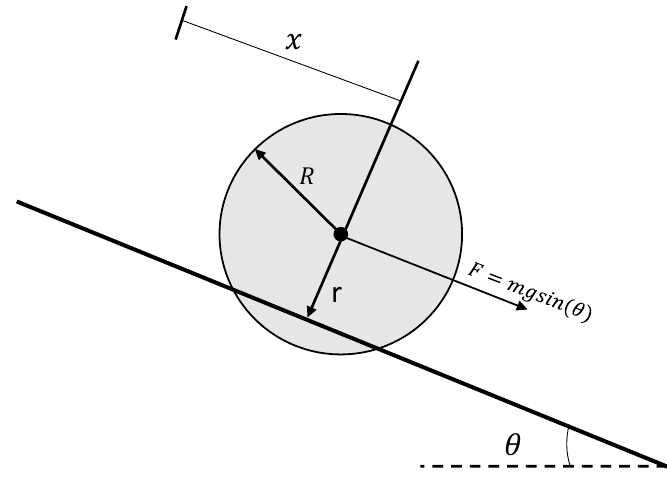
Figure 11. Ball and beam system, where x is the position of the ball measured from the left end of the rail, θ is the inclination of the rail with respect to the horizontal, and R and r represent, respectively, the radius of the ball (spherical) and the radius of gyration of the ball about the edges of the